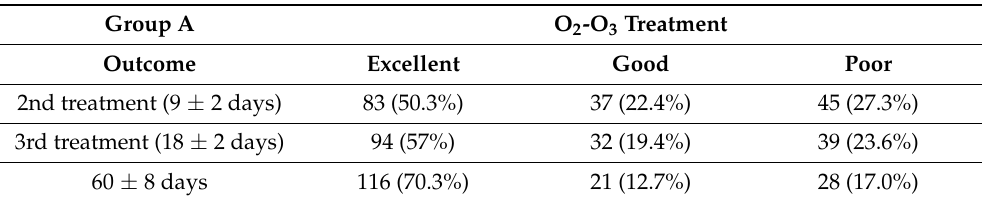
Table 2. Outcomes of group B (153 patients) after treatment (oxygen–ozone treatment was combined with 800 mg/day of ALA + 600 mg/day of PEA + 200 mg/day of myrrh orally). Group B O 2 -O 3 Treatment + ALA, PEA, and Myrrh Outcome Excellent Good